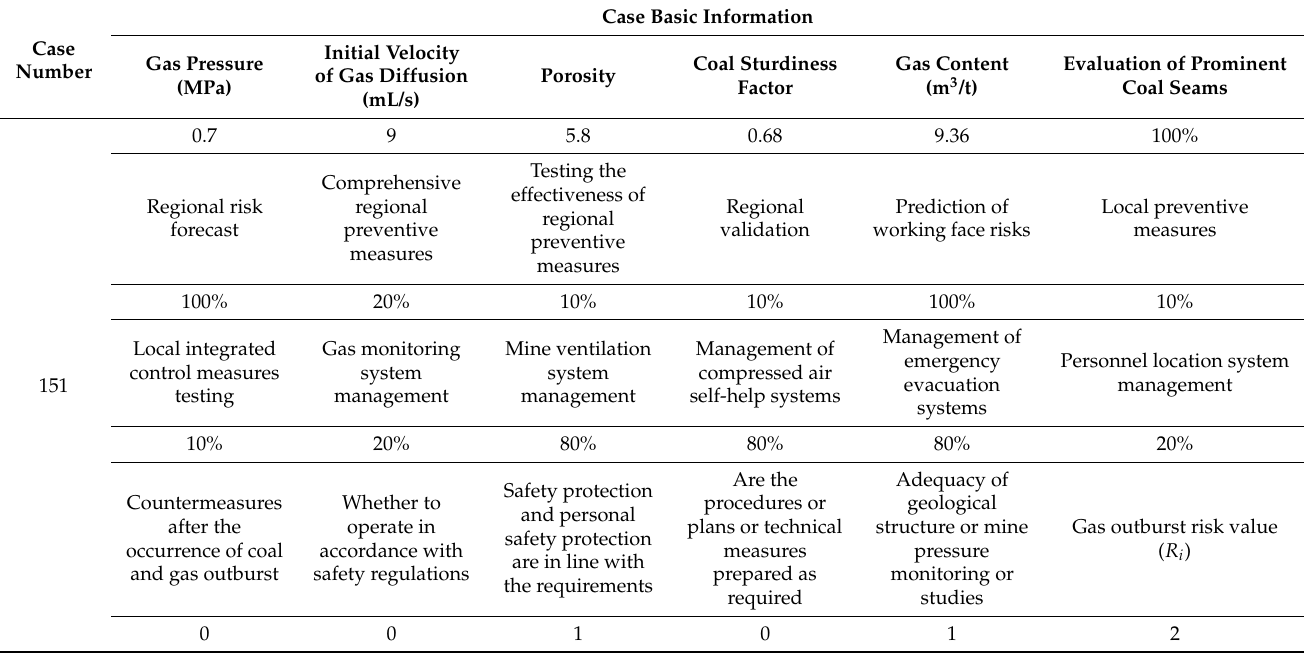
Table 12. Case matching analysis